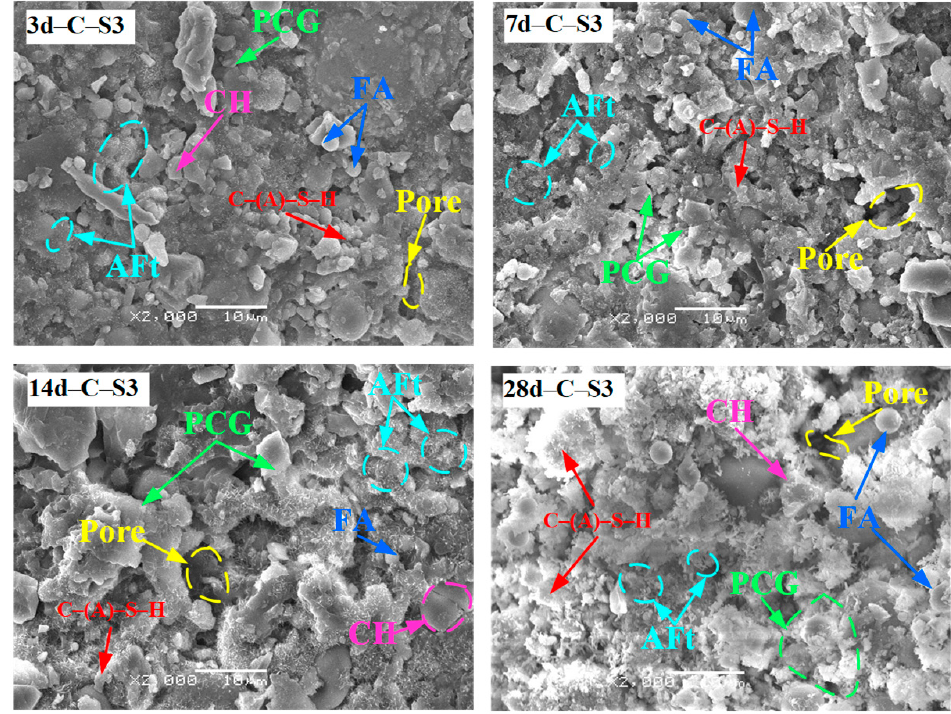
Figure 13. SEM results of C-S3 group samples.